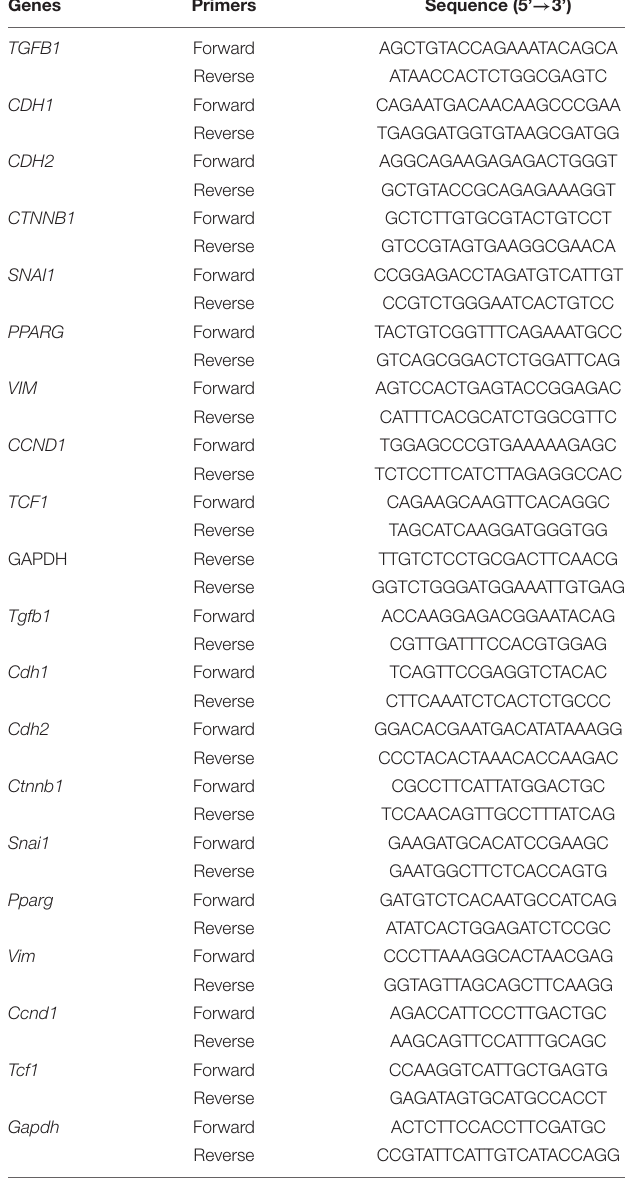
TABLE 1 | Primers used in this